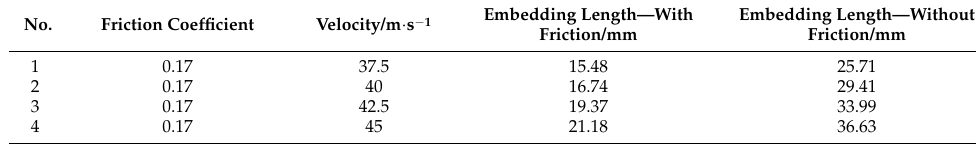
Table 3. Simulation experimental design and